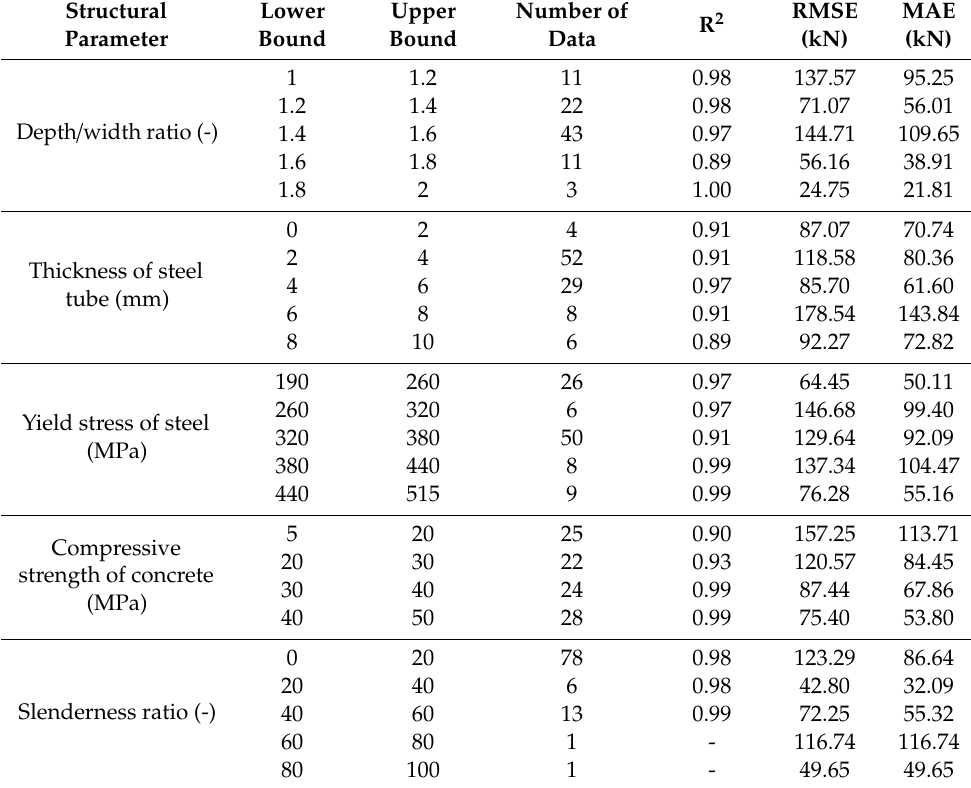
Table 6. Error analysis of prediction performance with respect to di ff erent ranges of values of structural